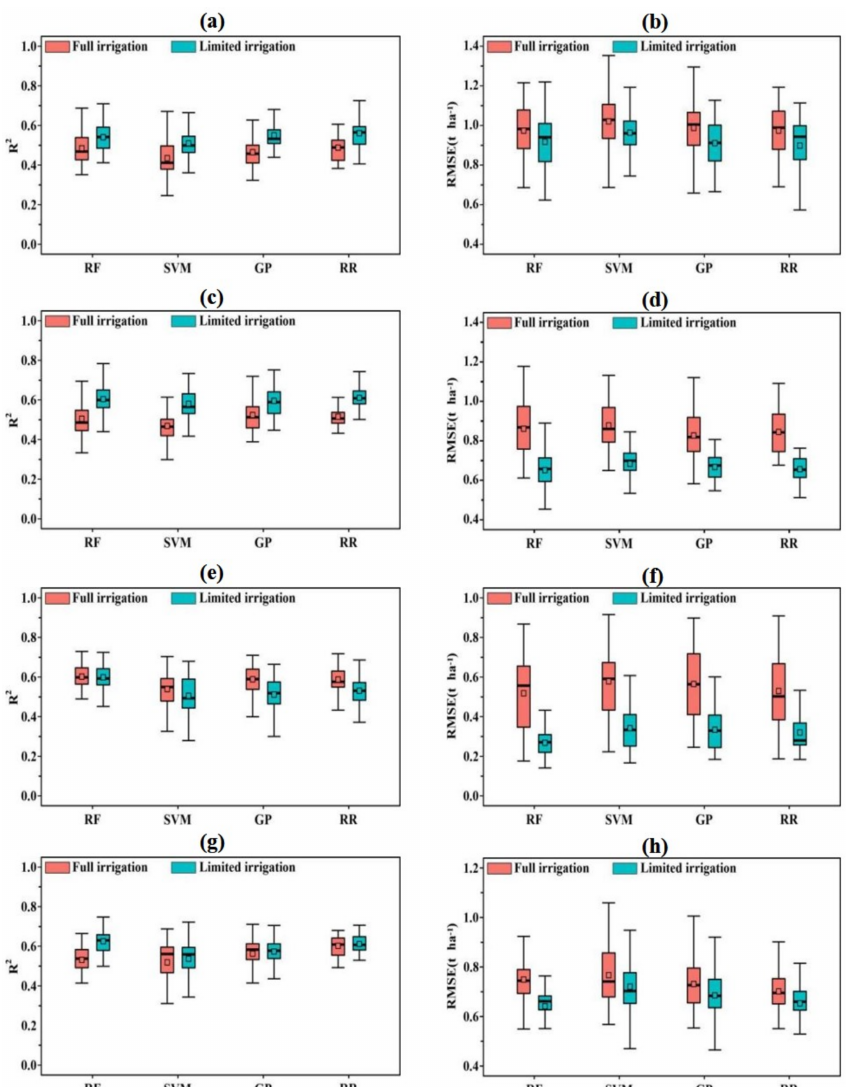
Figure 6. The statistical distributions of the prediction accuracy of each machine learning algorithm for grain yield prediction in the test phases; ( a ) distributions of R 2 at the heading stage; ( b ) distribu- tions of RMSE at the heading stage; ( c ) distributions of R 2 at the flowering stage; ( d ) distributions of RMSE at the flowering stage; ( e ) distributions of R 2 at the early grain filling stage; ( f ) distributions of RMSE at the early grain filling stage; ( g ) distributions of R 2 at the mid-grain filling stage; ( h ) distributions of RMSE at the mid-grain filling stage. Abbreviations: RF, random forest; SVM; support vector machine; GP, Gaussian process; and RR, ridge